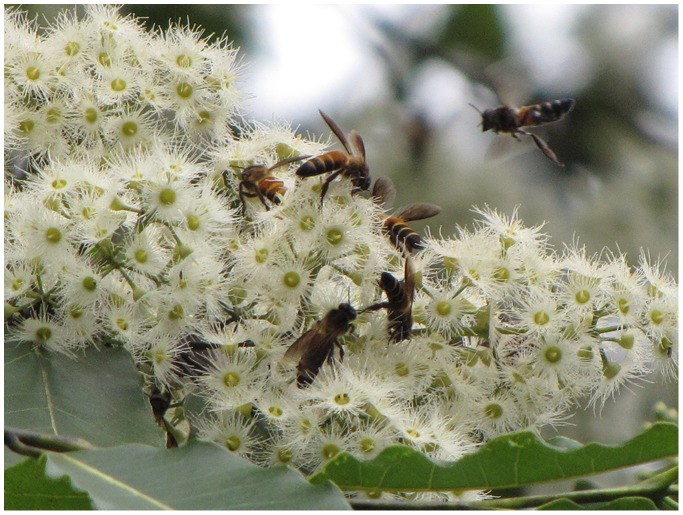

A. dorsata folragers in high density on Eucalyptus flowers.